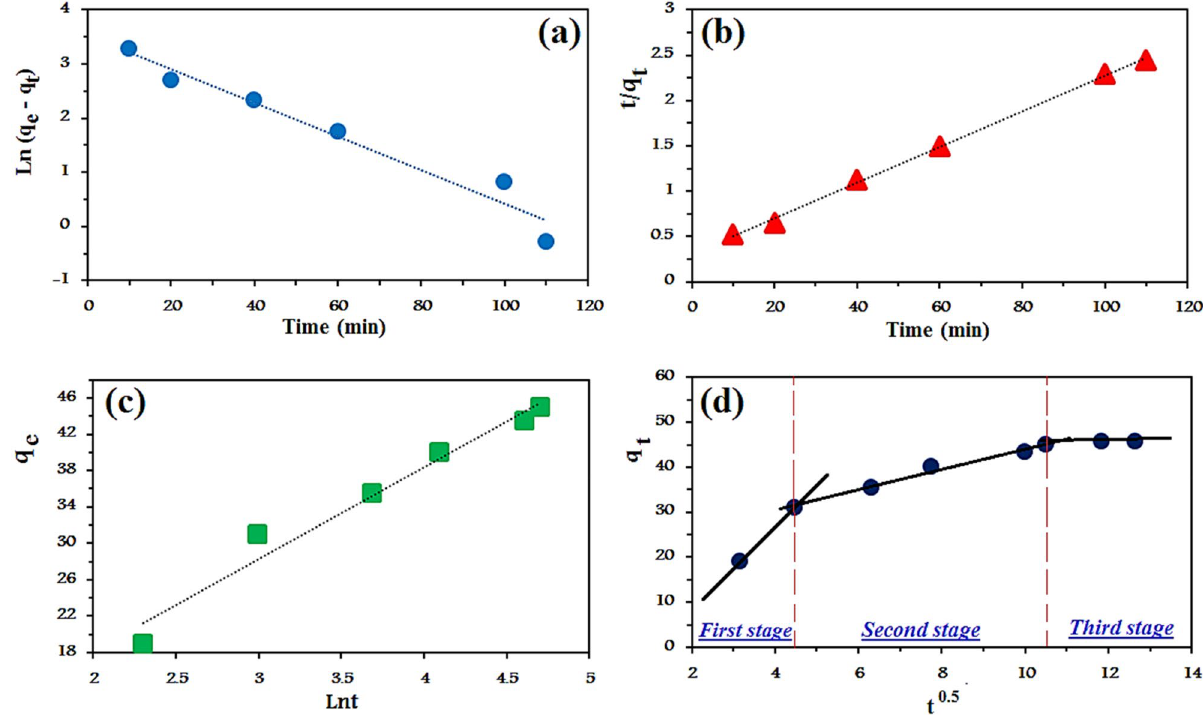
Figure 12. Linear kinetic models of ( a ) PFO ( b ) PSO ( c ) Elovich, and ( d ) intra-particle diffusion for RO16 adsorption by lignocellulosic sawdust-Fe/Zn bio-nanocomposite.